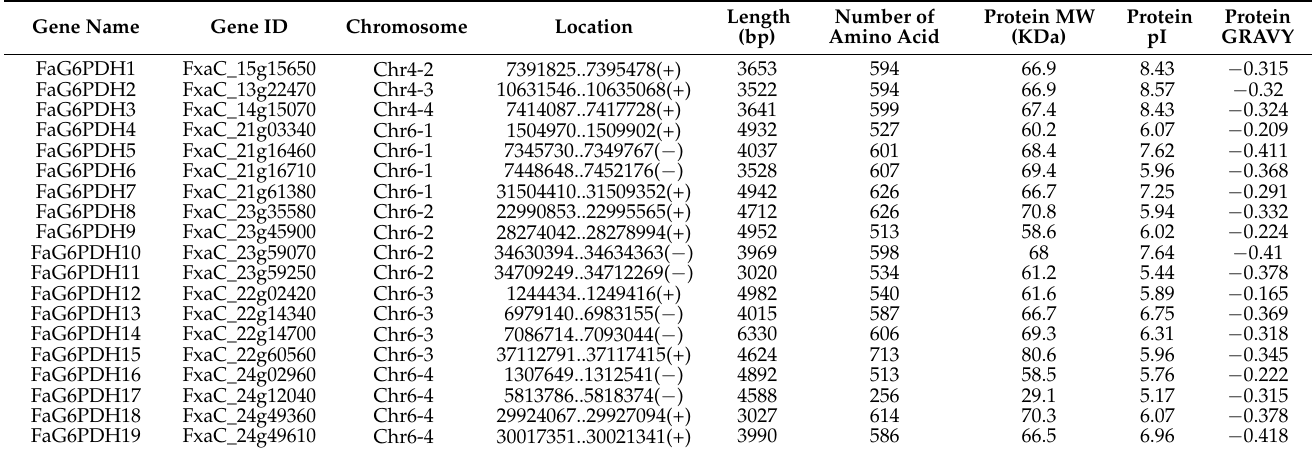
Table 1. List of FaG6PDHs identified in